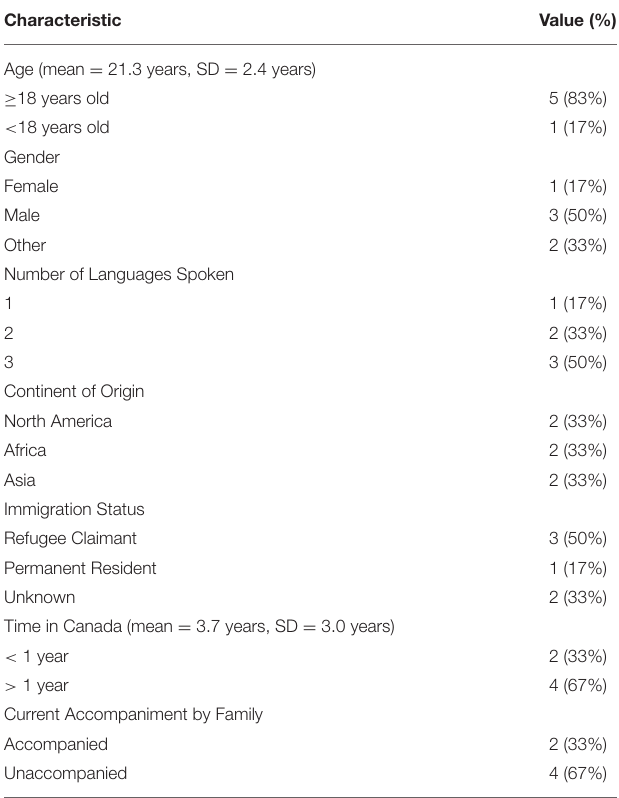
TABLE 1 | Demographic characteristics of YWS youth participants ( N =